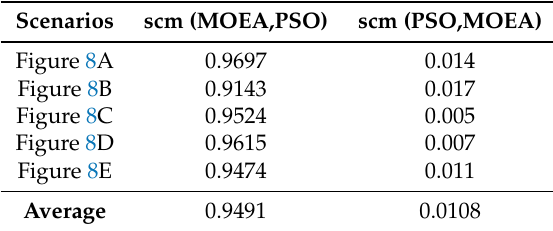
Table 3. Set coverage metric results